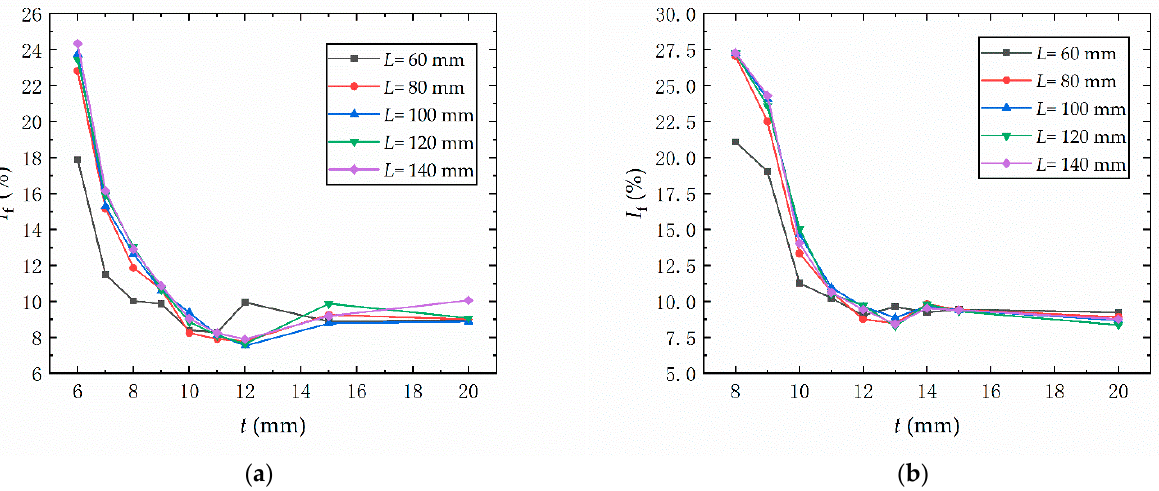
Figure 11. Influence of hollow section parameters on I f : ( a ) hollow mandrel scheme 1; ( b ) hollow mandrel scheme 2.